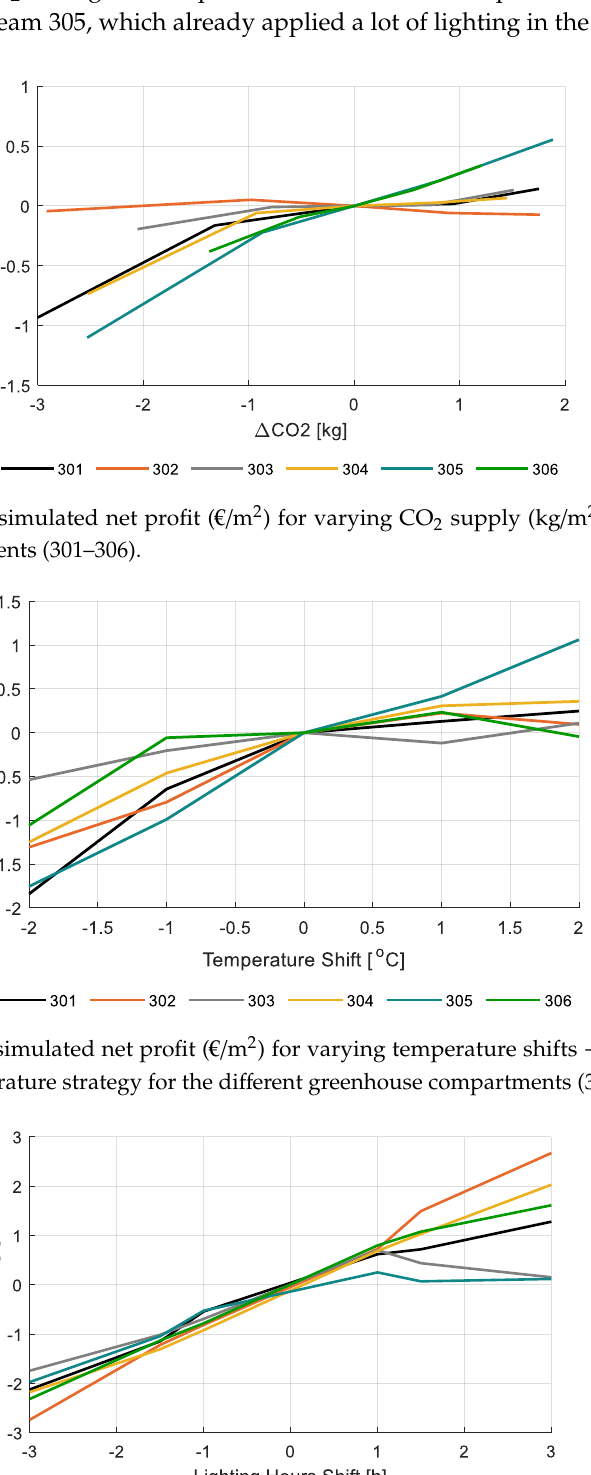
Figure 20. Change in simulated net profit (€/m 2 ) for varying temperature shifts −2 to +2 o C on the applied heating temperature strategy for the different greenhouse compartments (301 – 306).